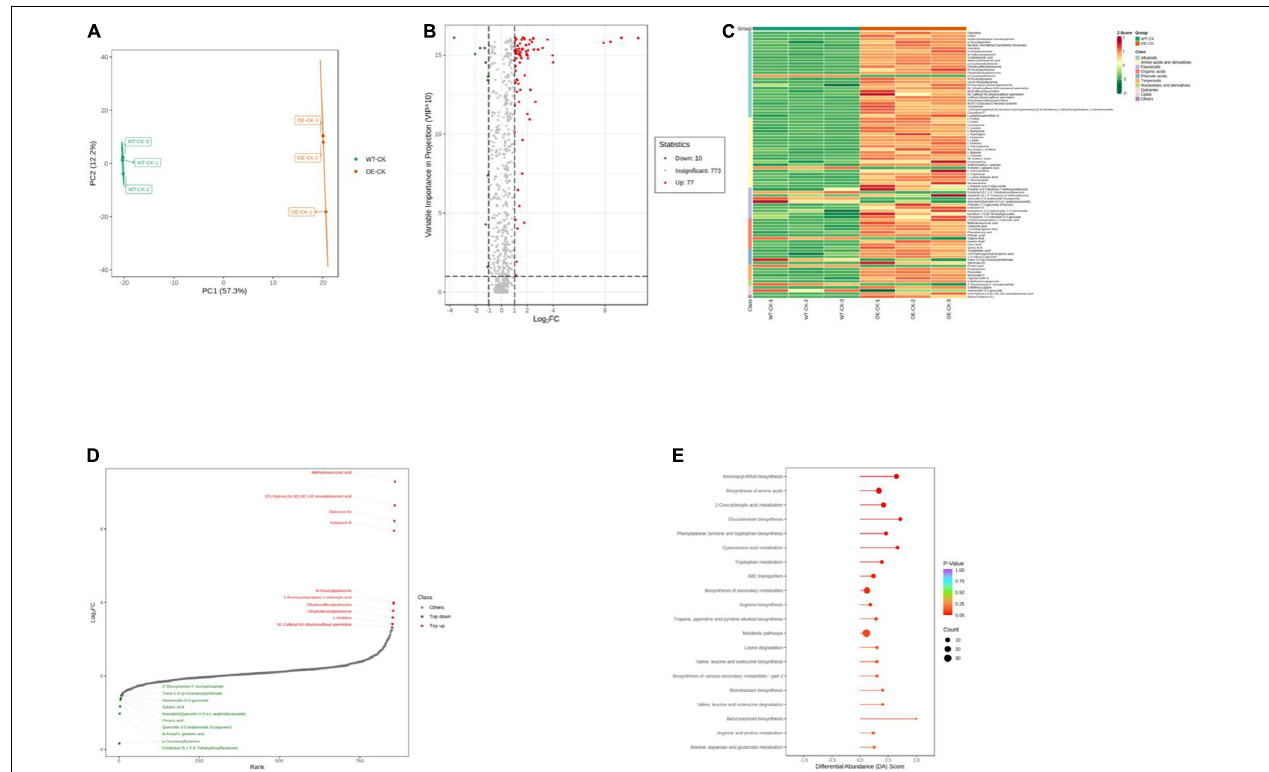
FIGURE 6 | Qualitative and quantitative analyses of differentially expressed metabolites in WT and OE plants. (A) PCA score plots for the mass spectra data of WT and OE samples. The abscissa represents the first principal component (PC1), while the ordinate represents the second principal component (PC2). (B) Volcano plot of differentially expressed metabolites between WT and OE plants. The abscissa represents the contents of differentially expressed metabolites between the two samples; a greater absolute value of the abscissa indicates a greater difference in relative content. A larger ordinate value indicates a more credible difference. Red scatter indicates metabolites that were significantly upregulated; green scatter indicates metabolites that were significantly downregulated; gray scatter indicates metabolites with no significant difference. (C) Clustering analysis of the metabolome data from WT and OE plants. Heatmap representation of the levels of differentially expressed metabolites and the color indicated low (green) to high (red). Each line in the heatmap represents a metabolite. Ten classes were evident after the clustering analysis. (D) The top 10 upregulated and downregulated metabolites between WT and OE plants. Red dots represent upregulated metabolites; green dots represent downregulated metabolites. (E) KEGG enrichment analysis of differentially accumulating metabolites between WT and OE samples. DA score represents the overall changes in all metabolites in the metabolic pathways; a score of 1 indicates upregulated trend, while a score of –1 indicates a downregulated trend. Each bubble in the plot represents the number of associated metabolites; P- values are indicated by